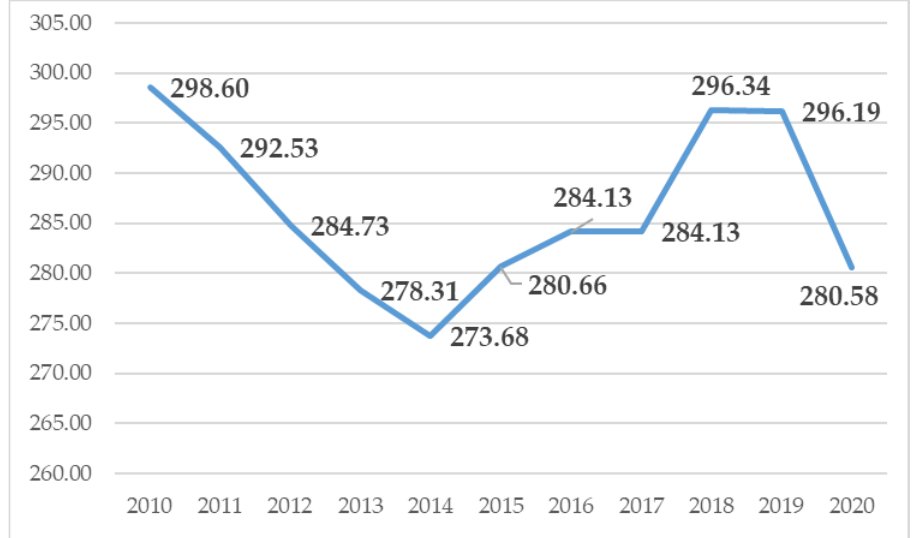
Figure 1. The emission of CO2 in Poland (in thousands of tons).